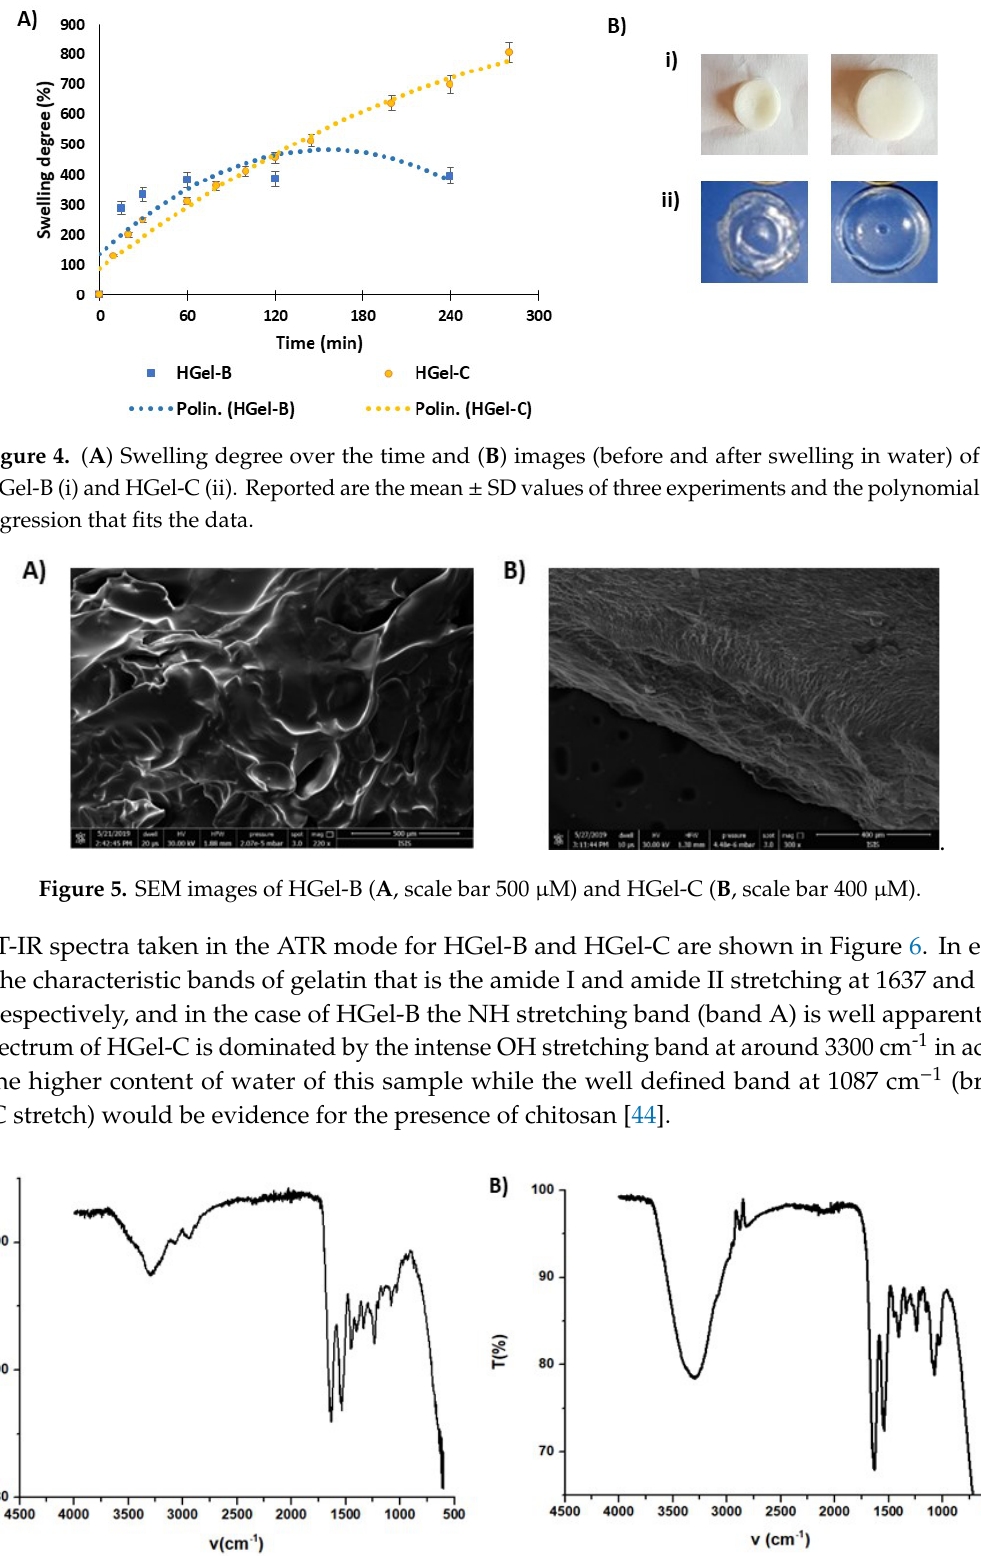
Figure 6 . Attenuated Total Reflectance (ATR)-IR spectra of HGel-B ( A ) and HGel-C ( B ).